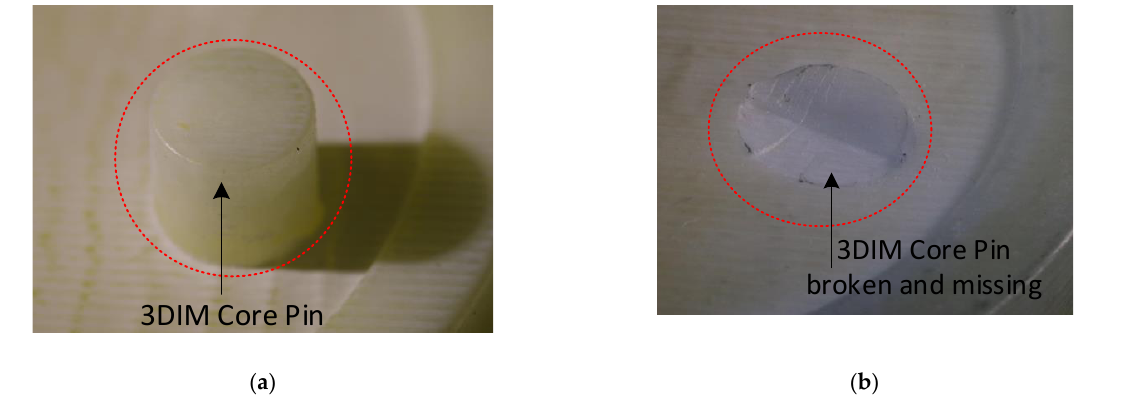
Figure 19. ( a ) 3DIM tool with an intact core pin before moulding; ( b ) 3DIM tool with a broken a missing core pin after moulding and part ejection during 3rd shot.